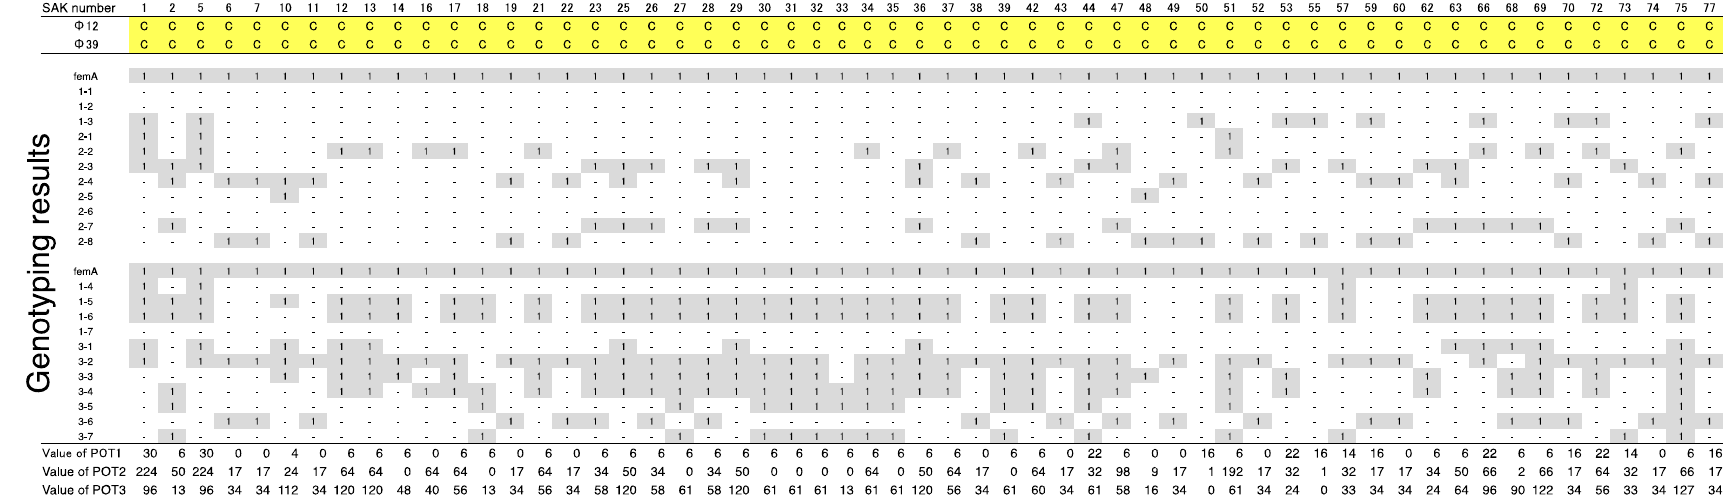
Table 1. Host ranges of S. aureus phages, Φ SA012 and Φ SA039, against S. aureus isolated from mastitic cows in Kushiro.